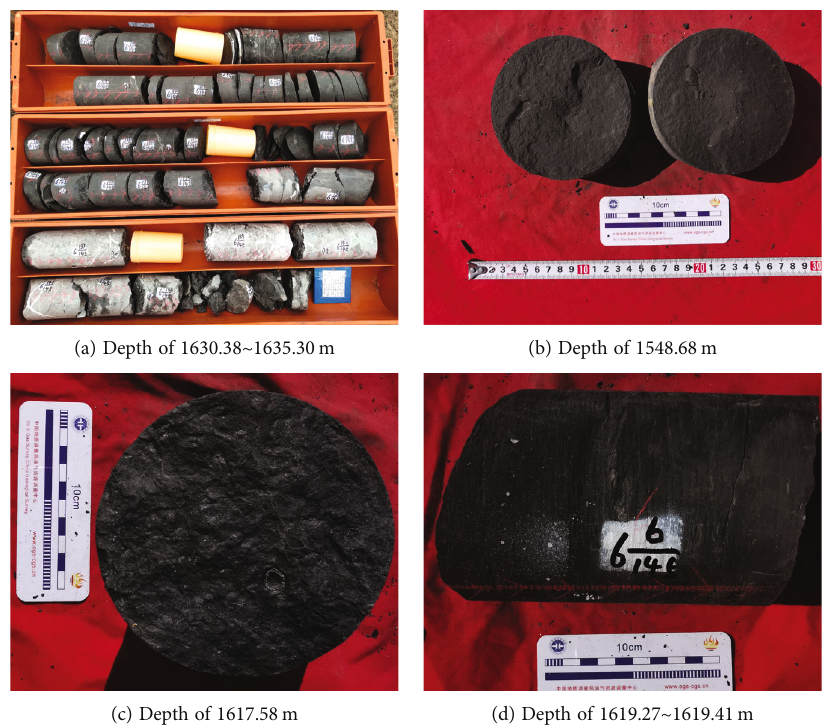
Figure 3: Core characteristics of shale in the fi rst member of Luzhai Formation: (a) the boundary between grey marl of Yaoyunling Formation and black mudstone of Luzhai Formation; (b) slightly developed foliation, 0.1 ~ 0.2mm thick; (c) black carbonaceous shale, rich in carbon; (d) black carbonaceous shale with dark grey marl